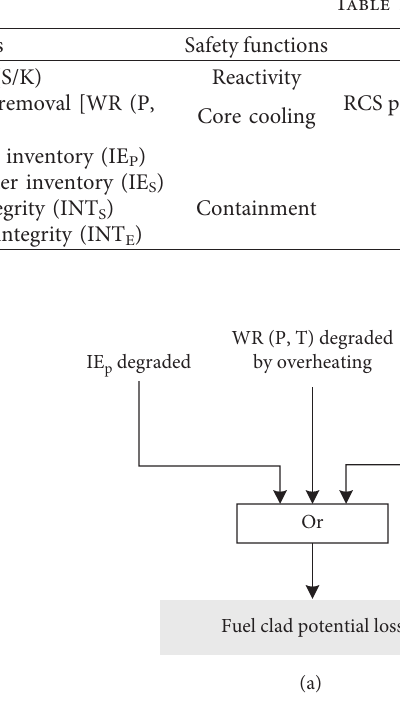
Figure 1: Fuel clad barrier initial